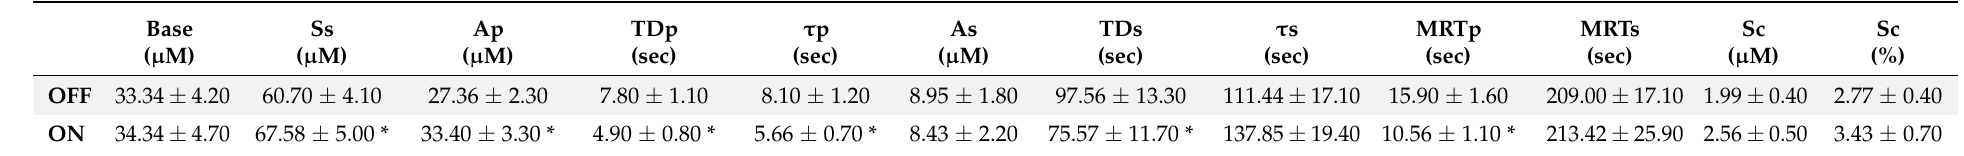
Table 2. Mean values ( ± SEM) of HHb on-kinetics recorded during constant-load exercise in both conditions (PEMF OFF; PEMF ON). Base, baseline; Ss, steady-state; Ap, amplitude of primary component; TDp, time delay for primary component; τ p, tau for primary component; As, amplitude of slow component; TDs, time delay for slow component; τ s, tau for slow component; MRTp, mean response time for primary component; MRTs, mean response time for slow component; Sc, magnitude of slow component. Asterisk indicates significant differences at p <